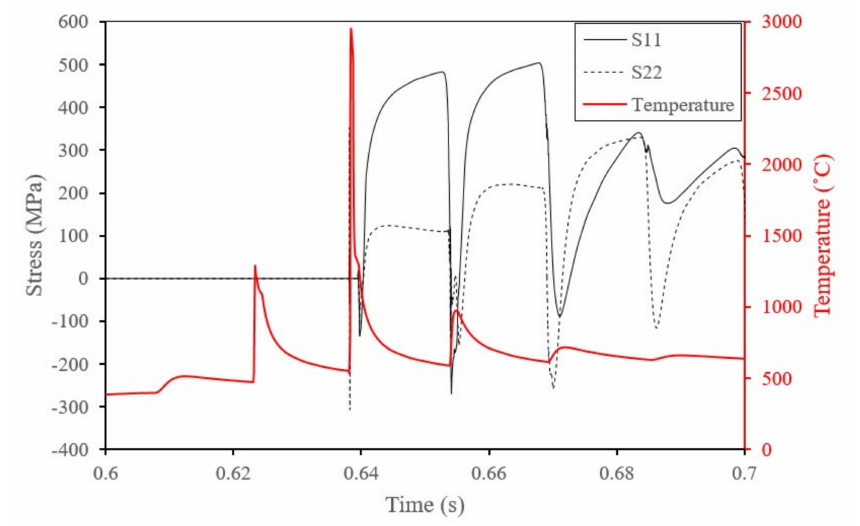
Figure 21. Non-linear temperature and stress evolution at 220 W, 650 mm/s, and 0.12 mm.